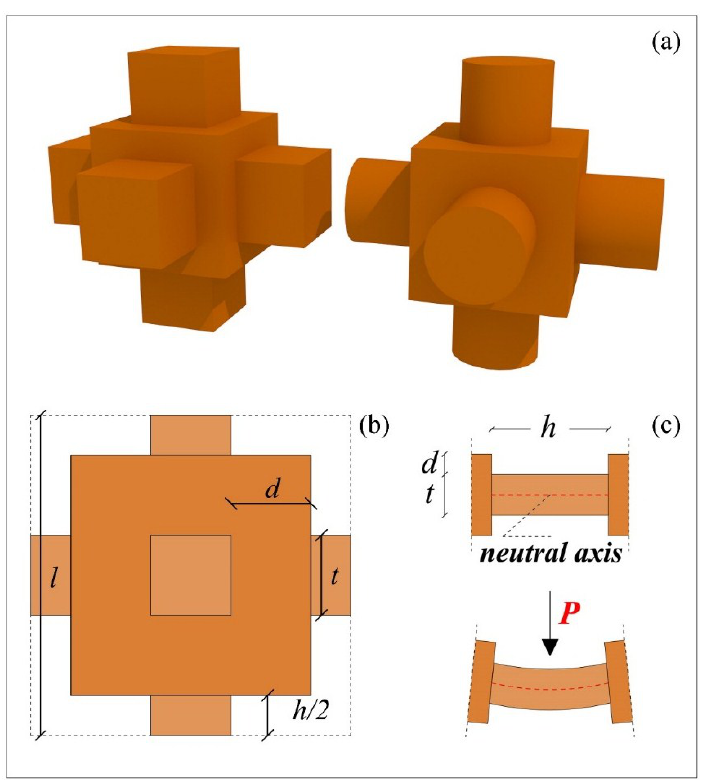
Figure 4. ( a ) Unit cells with ligaments having square and circular cross sections; ( b ) Characteristic lengths associated with ligaments and nodes; ( c ) Idealized bending behavior of a